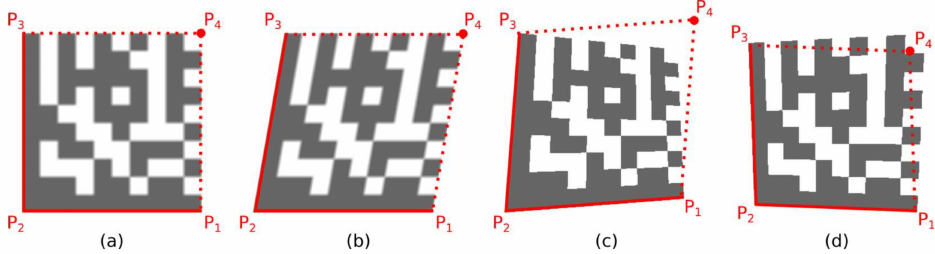
Figure 13. The initial estimate of the position of 4th point P 4 . ( a ) undistorted Data Matrix code; ( b ) skewed Data Matrix code; ( c , d ) perspective distorted Data Matrix codes.